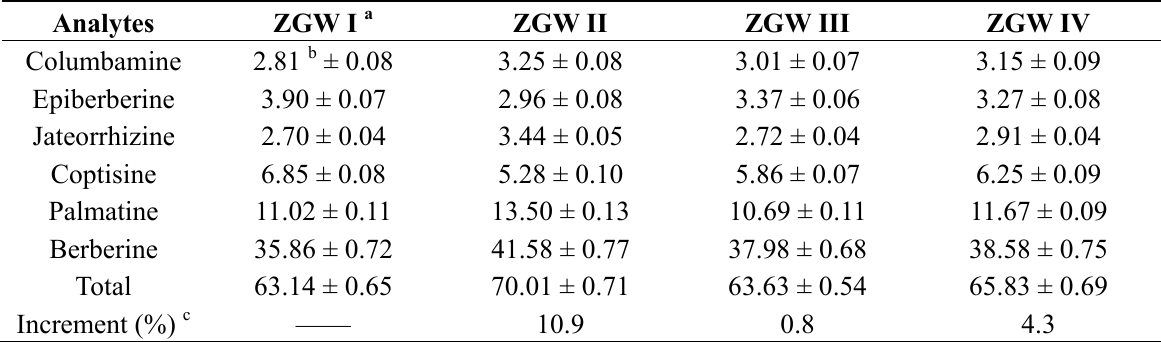
Table 5. Contents (mg/g) of investigated alkaloids in four kinds of Zoagumhwan